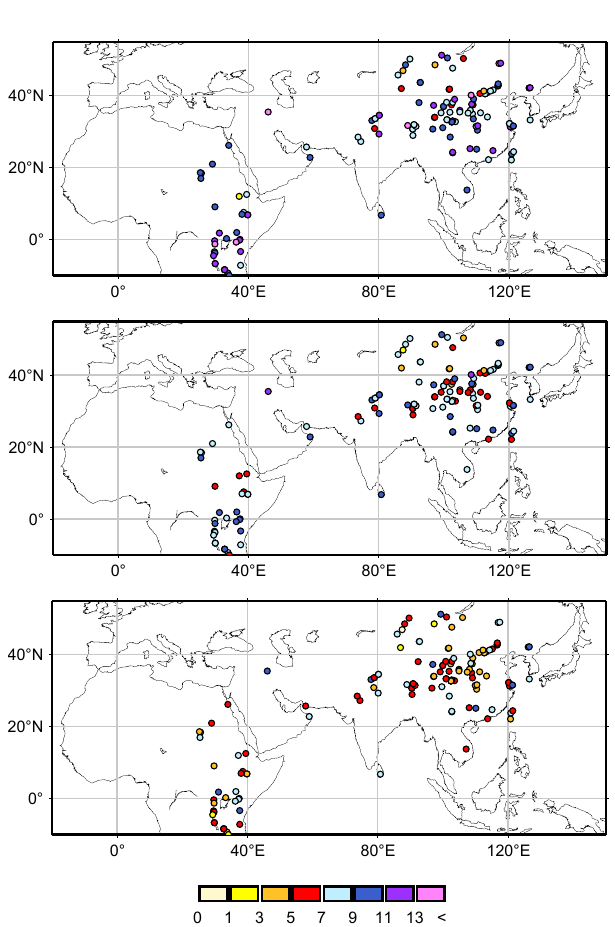
Figure 13. Reconstructed start (upper panel), mid and end (lower panel) time of the wettest period during the Holocene (in ky before present), based on the synthesis of records by Wang et al.